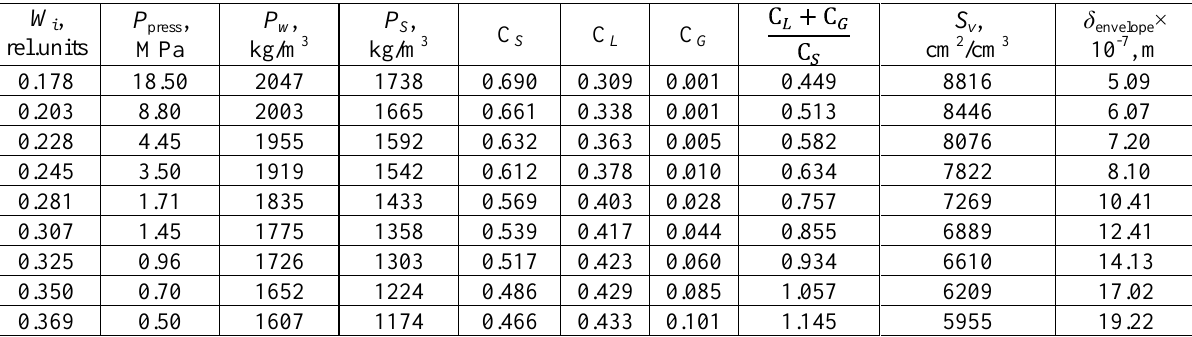
Table 3 . Calculated and experimental properties of studying mixture W , i